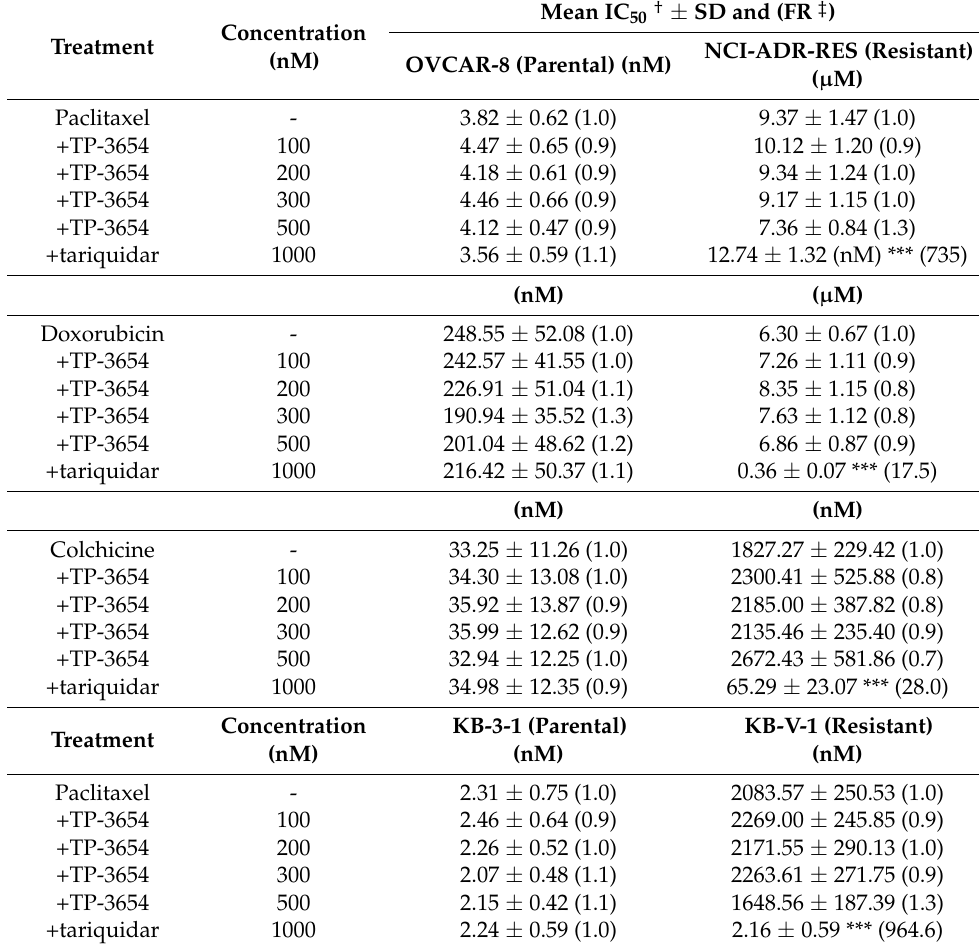
Table 2. Chemosensitizing effect of TP-3654 on ABCB1-mediated multidrug resistance in ABCB1- overexpressing human cell